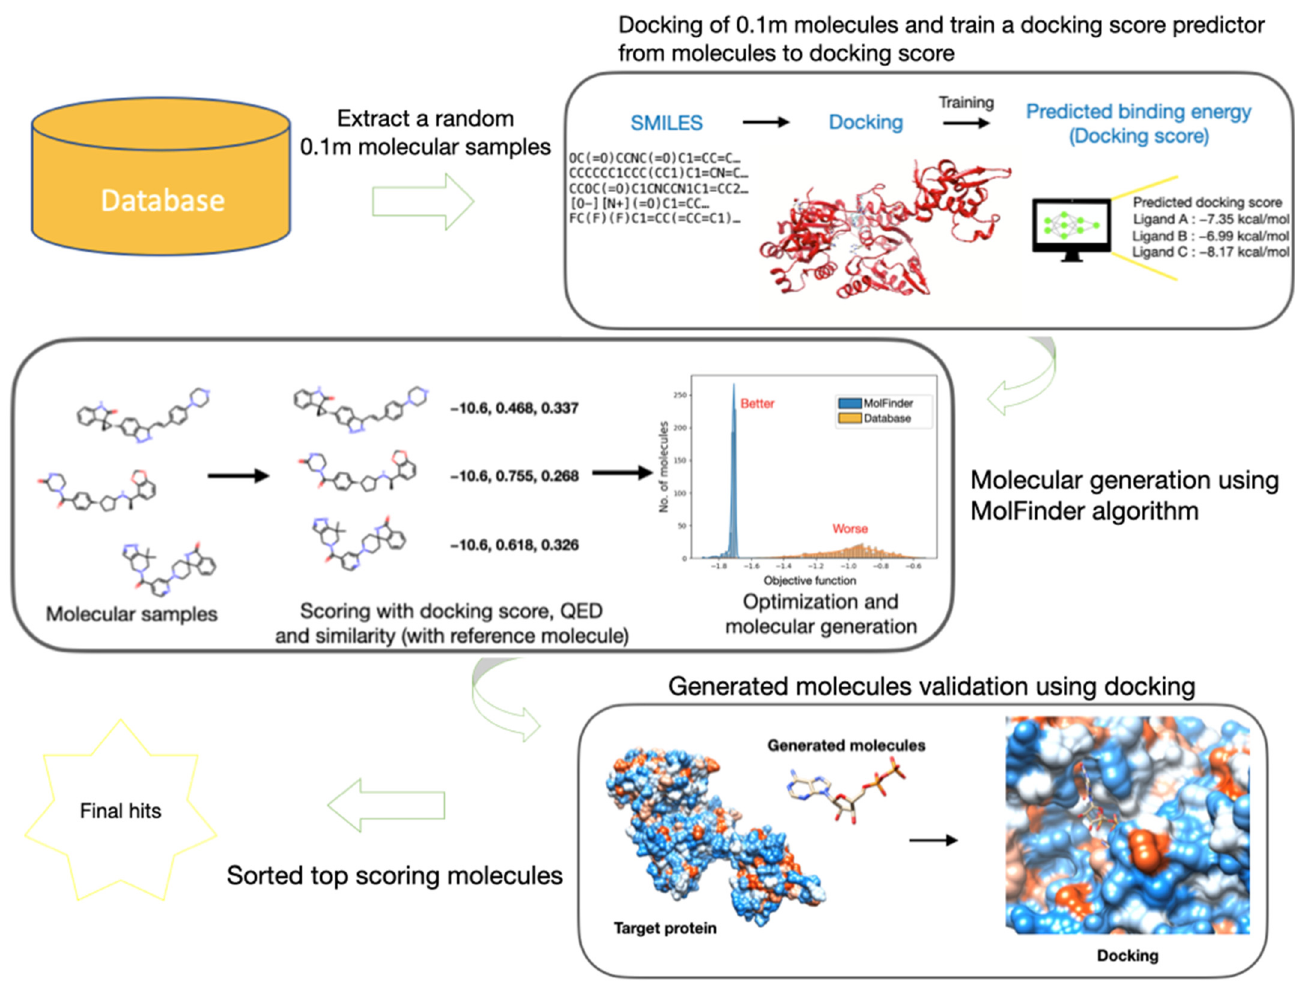
Figure 8. New drug development workflow used in this